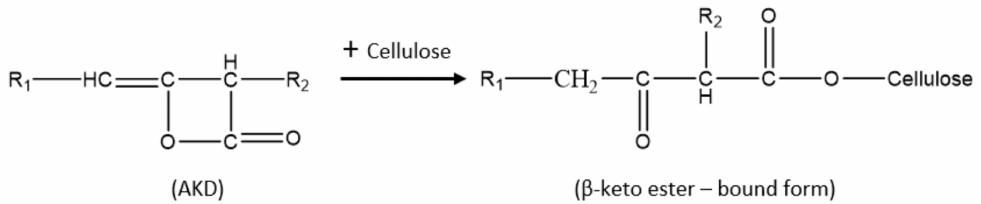
Figure 1. Reaction of alkyl ketene dimer (AKD) with cellulose.